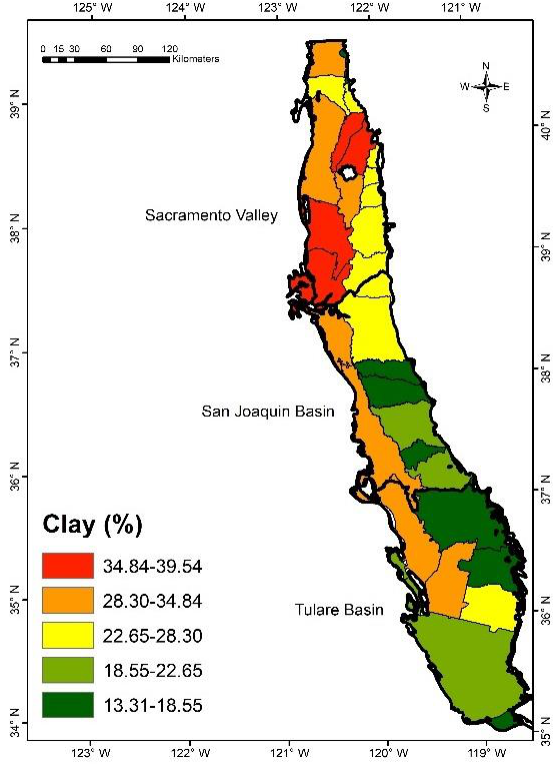
Figure 15. Elevation in Central Valley